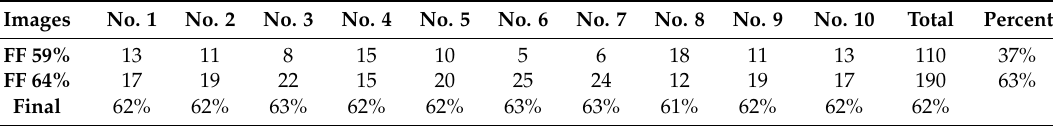
Table 2. Part of the results of fill factor estimation for the SONY